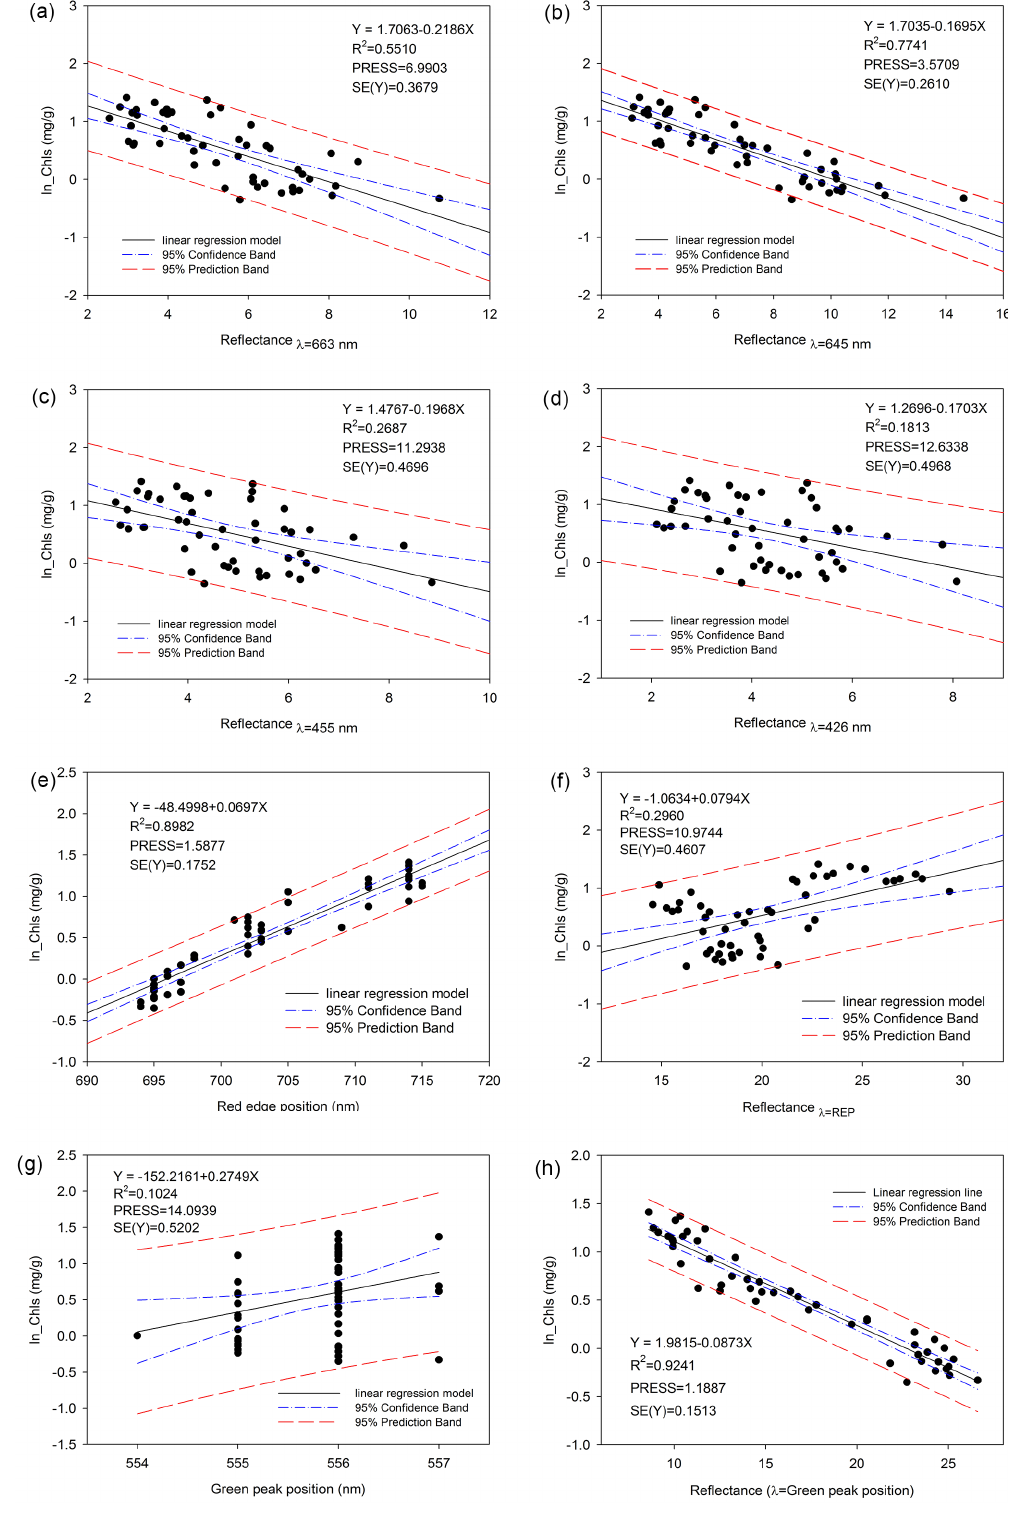
Figure 4. Reflectance-based empirical models with the ChlsPn/red edge/green peak variables for leaf total chlorophyll content